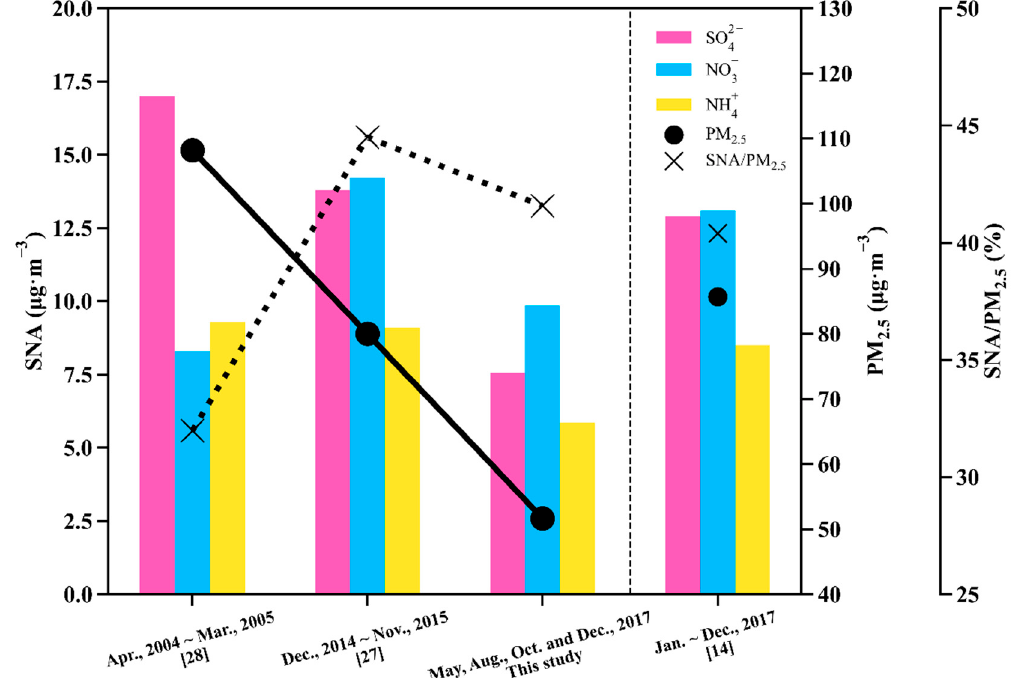
Figure 1. Comparisons of concentrations of PM 2.5 and WSIIs with previous results in the cities of Hangzhou and Handan.